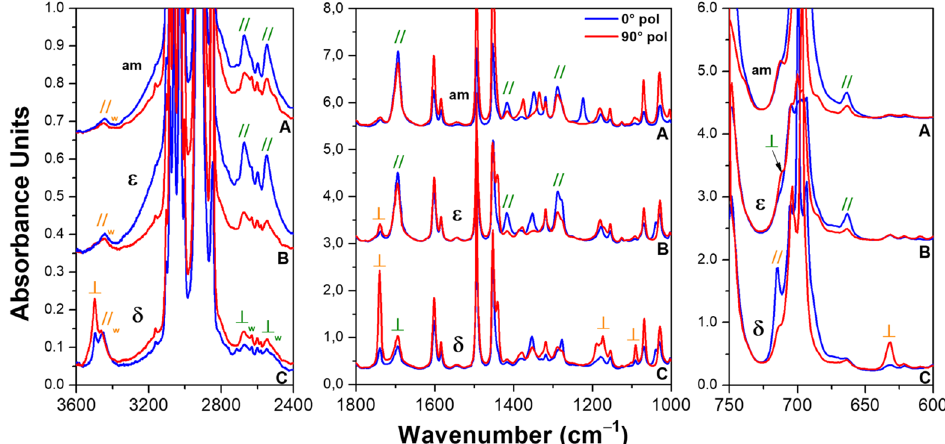
Figure 3. Polarized FTIR spectra measured with the polarization plane parallel (blue lines) and per- pendicular (red lines) to the film stretching direction, in three spectral ranges (3600–2400, 1800–1000 and 750–600 cm − 1 ), of axially oriented sPS films: ( A ) zig-zag planar mesomorphic; ( B ) CC ε form; ( C ) CC δ form. The labels // and ⊥ indicate that the guest peak absorbance was higher for the spectra with the polarization parallel and perpendicular to the film stretching direction, respectively. The green and orange labels indicate the peaks corresponding to the dimeric and isolated BA, respec- tively.